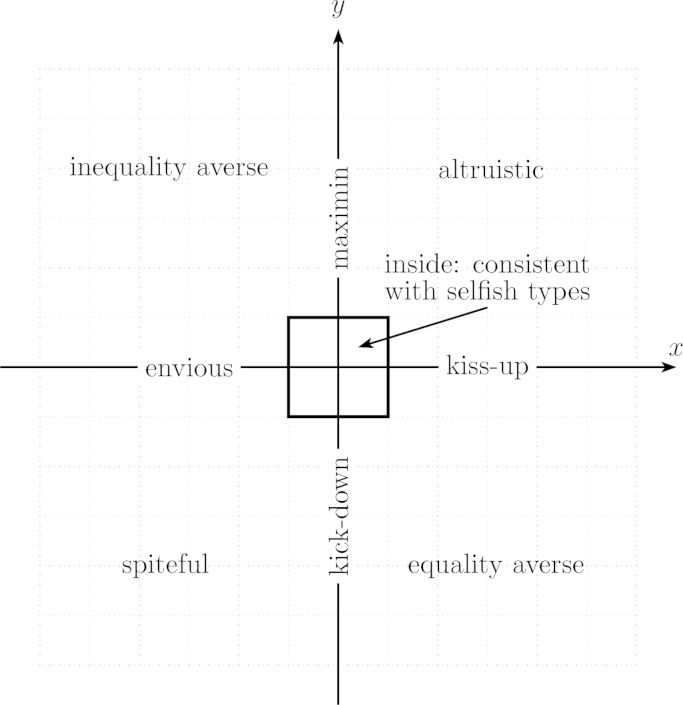
Distributional types in (x, y) space.